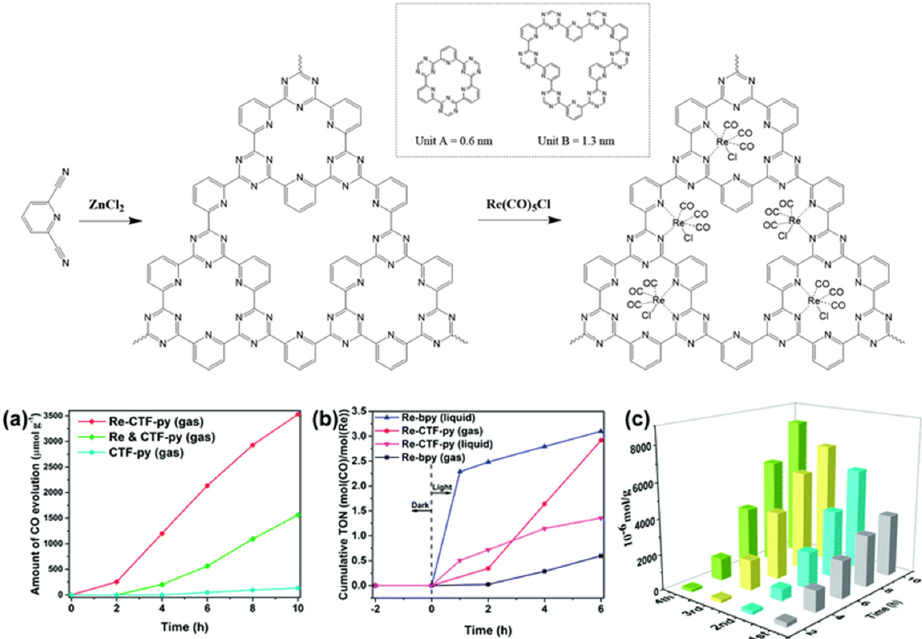
Figure 13. Top : Synthesis of CTF-py and Re-CTF-py materials. The inset shows the two types of pores (unit A and unit B). Down : (a) CO evolution over CTF-py, Re-CTF-py and the physical mixture of CTF-py and Re ( CO) 5 Cl (Re and CTF-py) in the solid–gas system. (b) Photocatalytic activity of Re-bpy and Re-CTF-py in solid–gas and liquid–gas systems. (c) Production yield of CO over the Re-CTF-py photocatalyst to measure its reproducibility by cycling tests. Copied with permission from RSC 2018 [45].